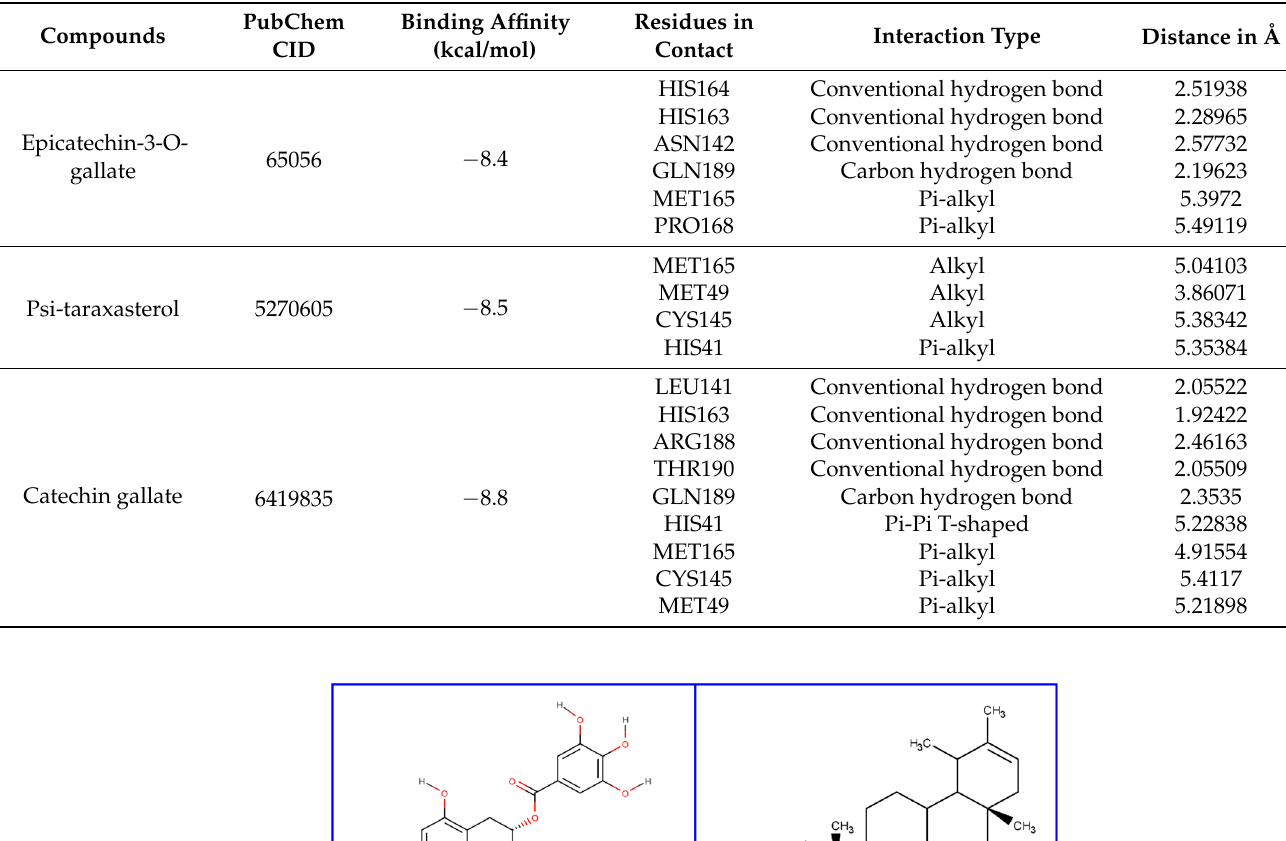
Epicatechin-3-O- gallate